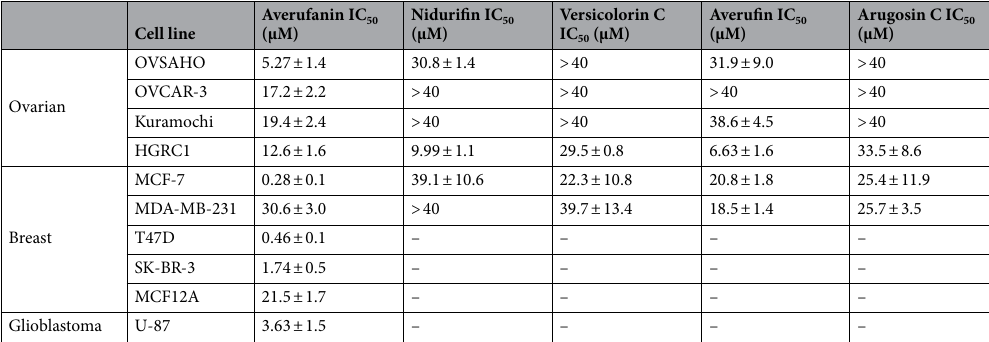
Table 1. IC 50 values of the compounds obtained from NCI-SRB Assay. R 2 > 0.8.